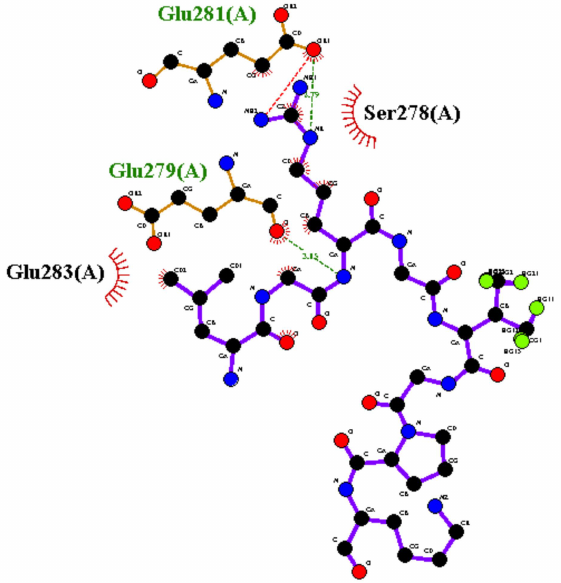
Figure 11. Binding site residues of BBM Fragment 1 protein with the peptide P4. P2 (dock10) formed three hydrogen bonds with LEU246, GLU279, and GLU285. As the ligand molecule P2 is larger than P4, many hydrophobic contacts (VAL296, TYR295, TYR245, GLY247, SER278, PRO276, LEU261, TYR249, and VAL284) formed in the complex. The interaction map indicates the bigger binding cavity that a peptide can